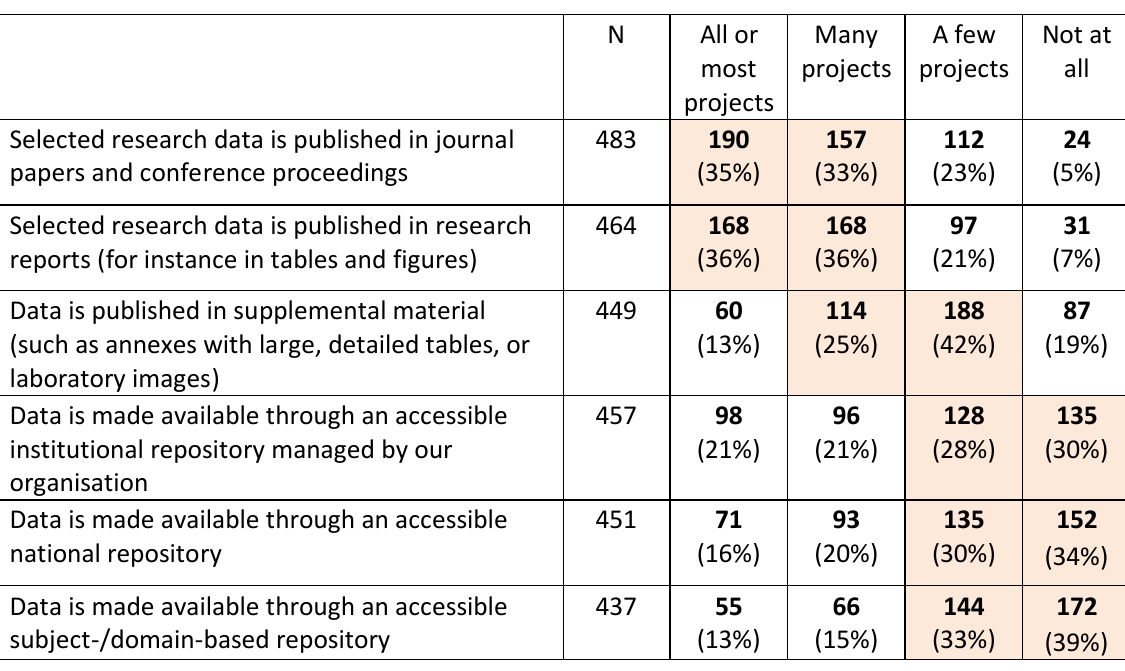
Table 7 : Publication of project research data (N =